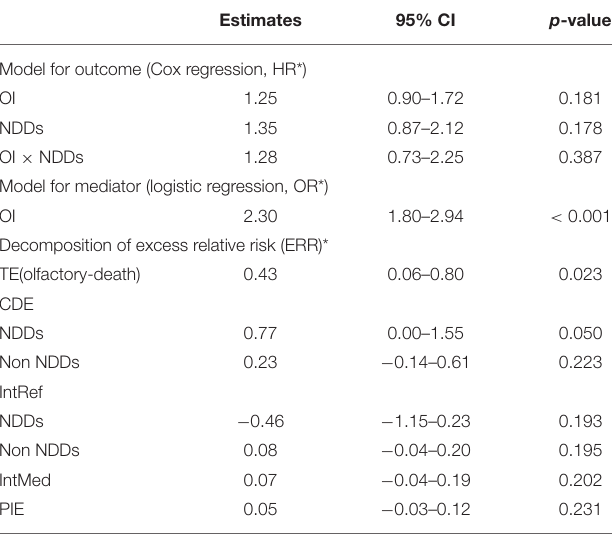
TABLE 2 | Results of the four-way decomposition analysis for the association between OI and mortality. Estimates 95% CI p